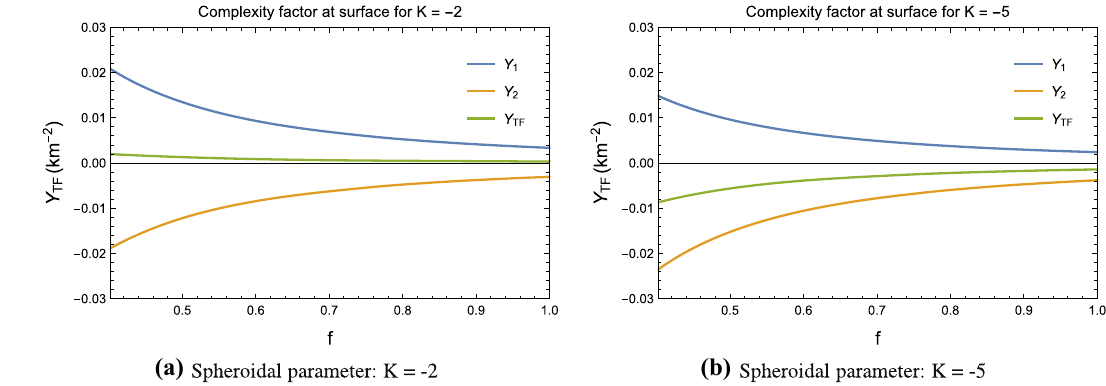
Fig. 1 Complexity factor: components and